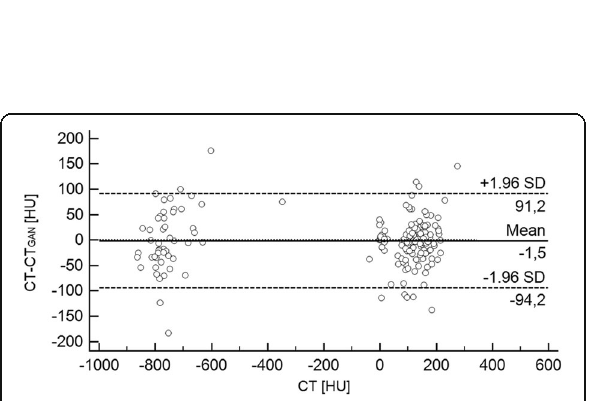
Fig. 4 Bland Altman plot comparing mean Hounsfield units between CT and CT GAN of all organ